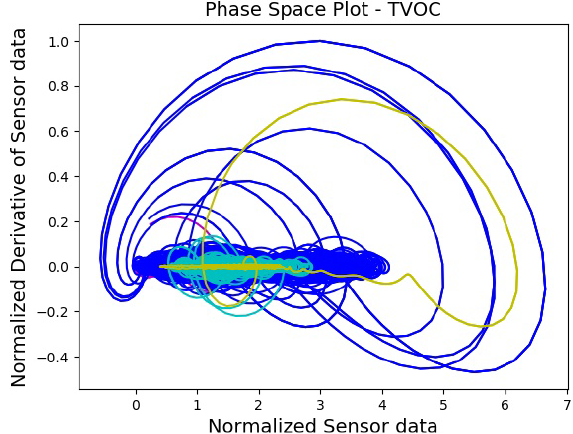
Figure 8. A phase space example of campaign data for the SGP30 sensor, TVOC output, and the four classes of VILE.